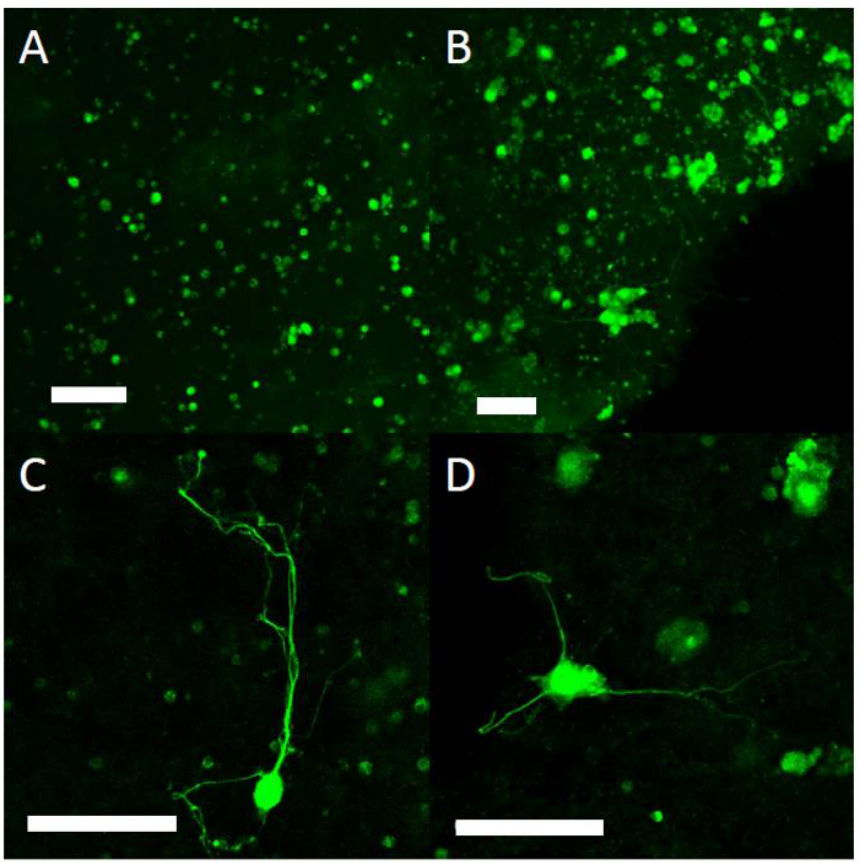
Figure 7. Neurite extension of PC12 cells in collagen-GMA hydrogel. PC12 cells were mixed with collagen-GMA hydrogel-forming solution, UV-irradiated for 10 min and placed into an incubator at 37 °C/5% CO 2 for 7 days. ( A ) Immediately after incubation cells were observed throughout the collagen-GMA hydrogel. ( B ) Following 7 days of NGF exposure, PC12 cells were observed extend- ing neurites throughout the collagen-GMA hydrogel, ( C ) with some neurites observed over 250 µm in length and ( D ) extending in multiple planes. Scale bar is 100 µm.